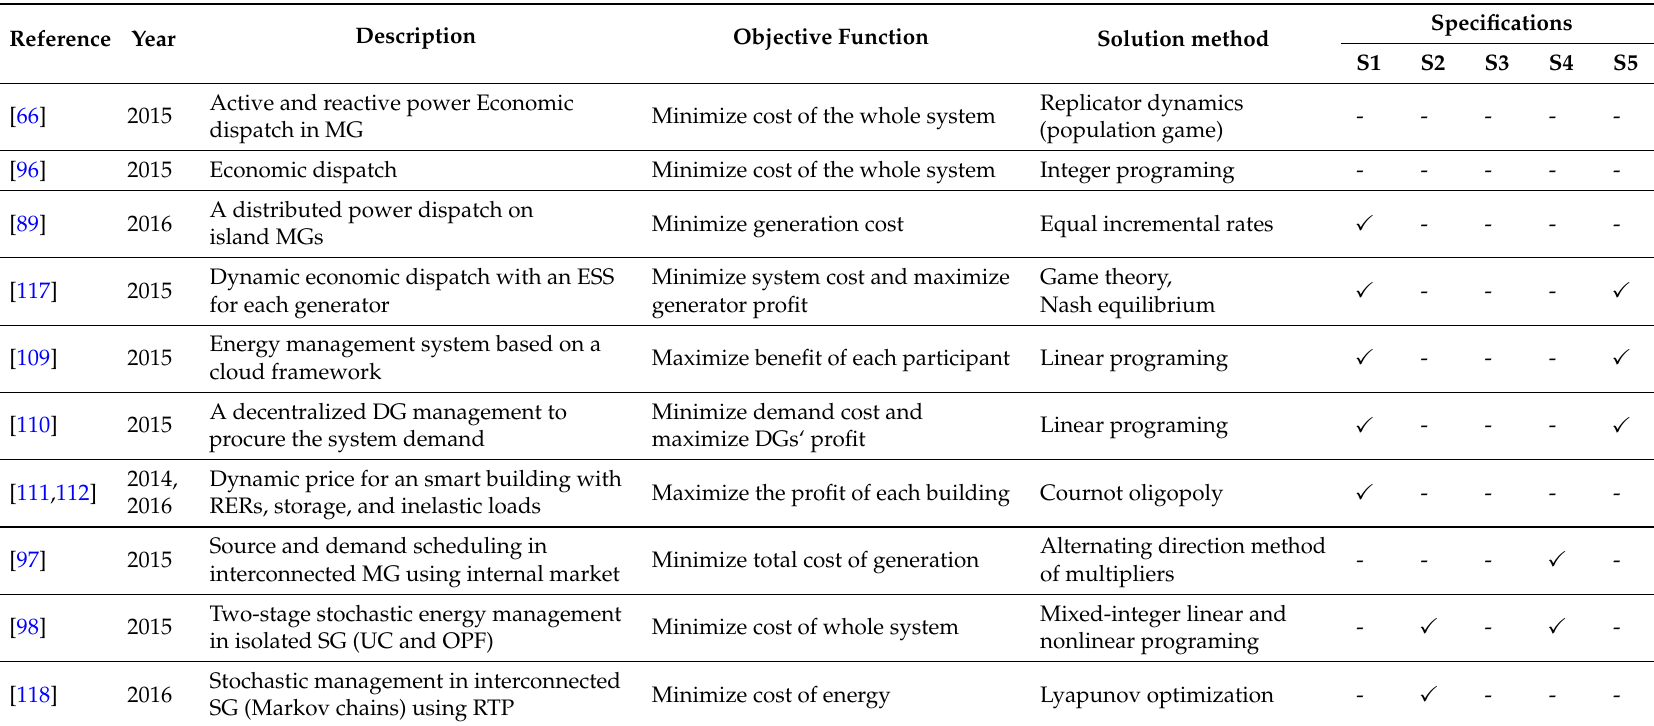
Table 3. List of recent research in SSM.